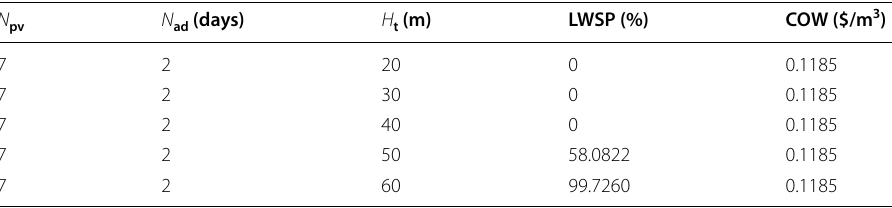
Table 9 Influence of total dynamic head on the cost and reliability of the system N pv N ad